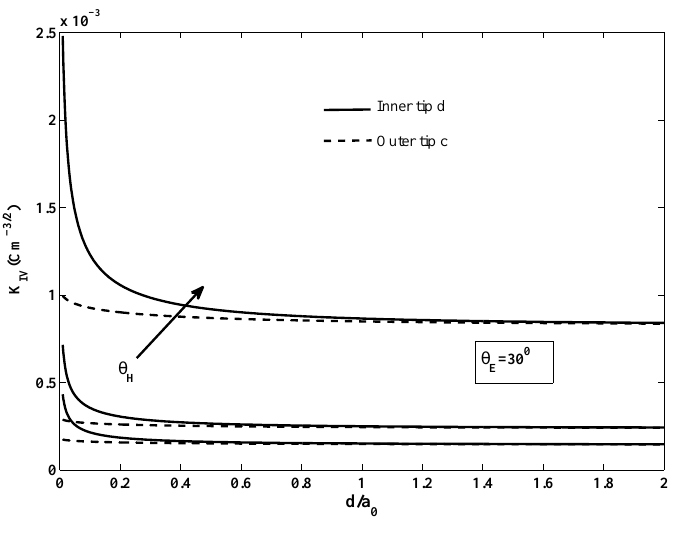
Fig. 15 EDIF versus inter-crack distance for different magnetic poling with fixed electric